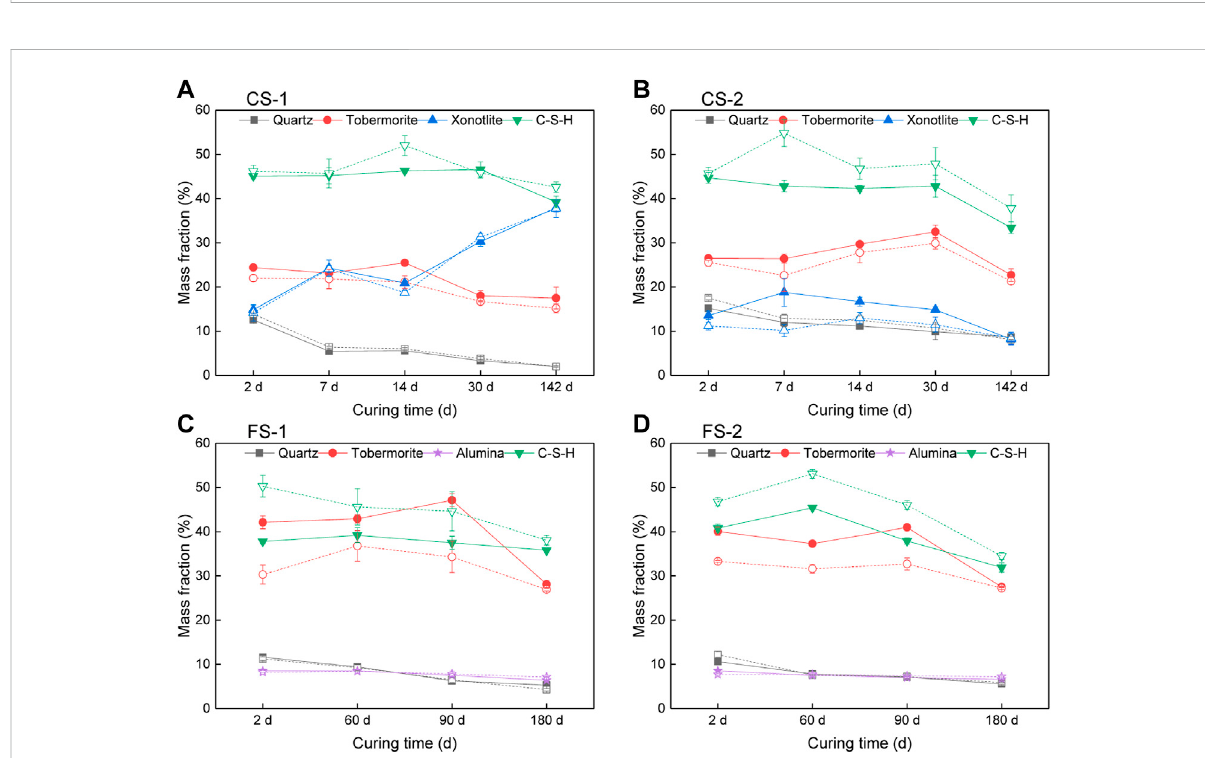
FIGURE 8 Quantitative X-ray diffraction analysis of hydrated cement using the external standard method ( fi lled symbols linked by solid curves) and the PONKCS method (hollow symbols linked by dash curves). (A) slurry CS-1 (B) slurry CS-2 (C) slurry FS-1 (D) slurry FS-2.